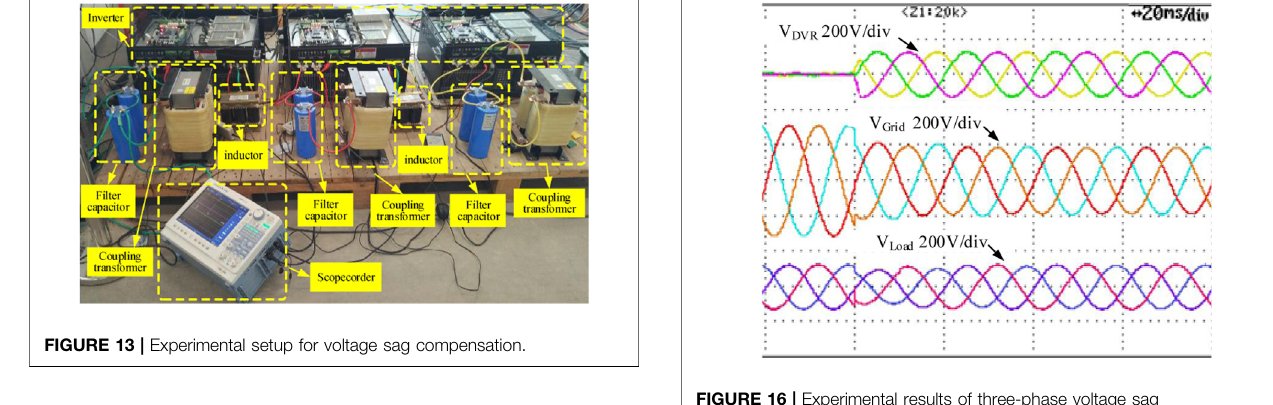
FIGURE 16 | Experimental results of three-phase voltage sag